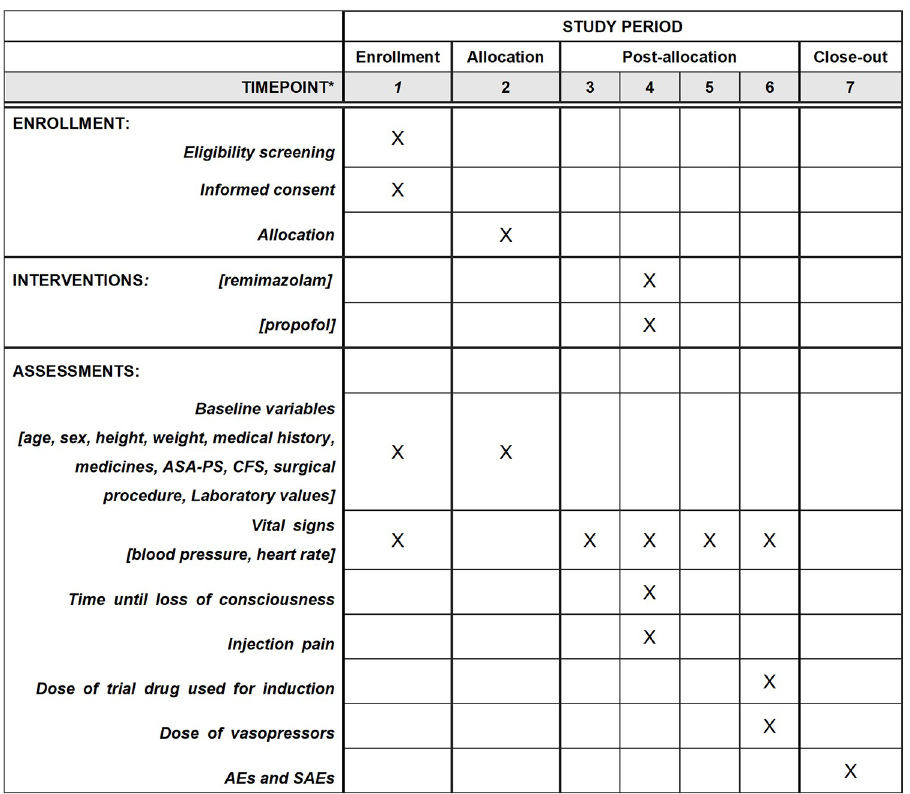
Fig 1. Participant timeline. � Timepoint 1: one day before surgery, Timepoint 2: after obtaining informed consent and till entering the operating room, Timepoint 3: in the operating room before anesthesia induction, Timepoint 4: from trial drug administration to loss of consciousness, Timepoint 5: from loss of consciousness to intubation, Timepoint 6: till 3 minutes after intubation, Timepoint 7: the day after the surgery. Medicines include antihypertensives, sleep inducing drugs, antipsychotics, and central nervous system agents without antidepressants. X indicates the timepoint at which each procedure in the protocol was carried out. Laboratory values include hemoglobin, creatinine, and albumin. AE adverse event, ASA-PS American society of Anesthesiology–physical status, CFS clinical frailty scale, SAE severe adverse event.